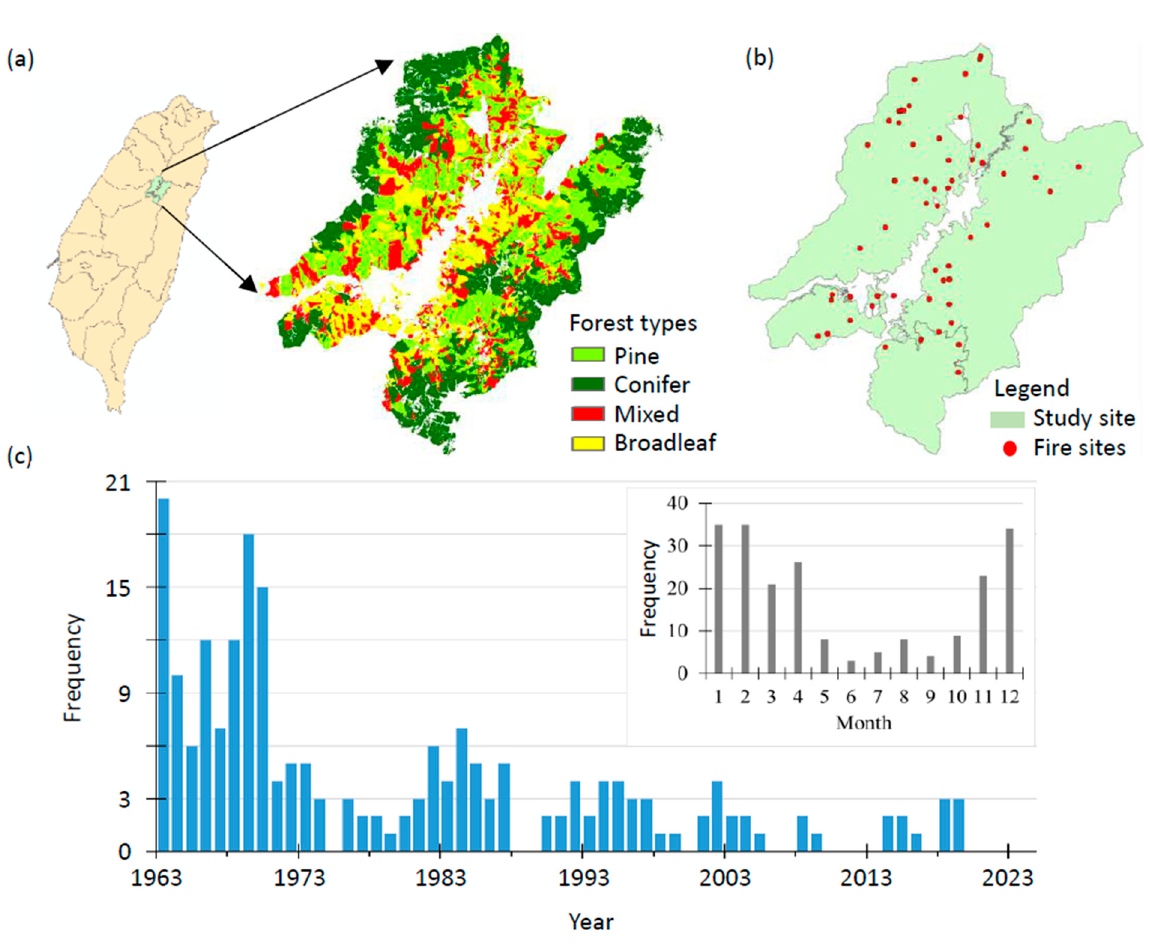
Figure 1. The biological data used in this study. The green polygon in ( a ) shows the geolocation of the forest with detailed forest types at the site. The total area of this study site is about 46,504 ha. Subfigure ( b ) depicts the sites of fires (red dots) occurring during the period from 1963 to 2019, and correspondingly the bar chart in subfigure ( c ) shows the fire frequency counted based on the year/month sequence. The white portion within the study site consists of rivers, inland lakes, and private agriculture land.